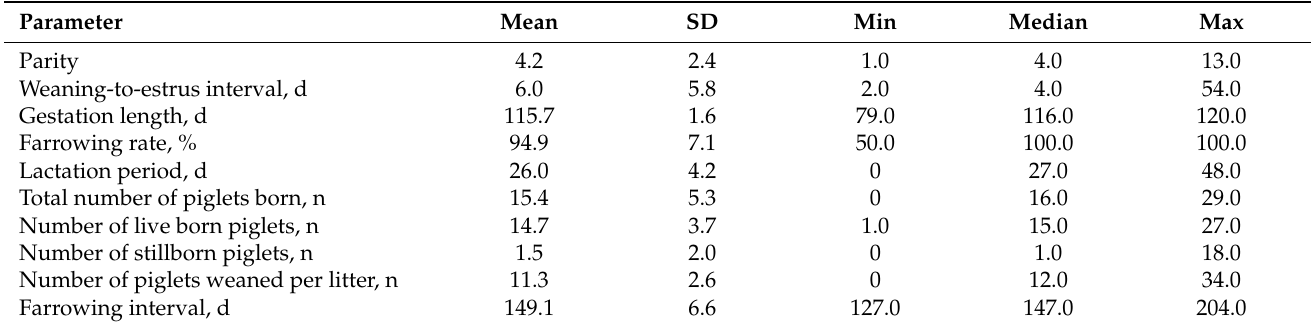
Table 2. Descriptive statistics of sow-related factors ( n = 1497 inseminations records).